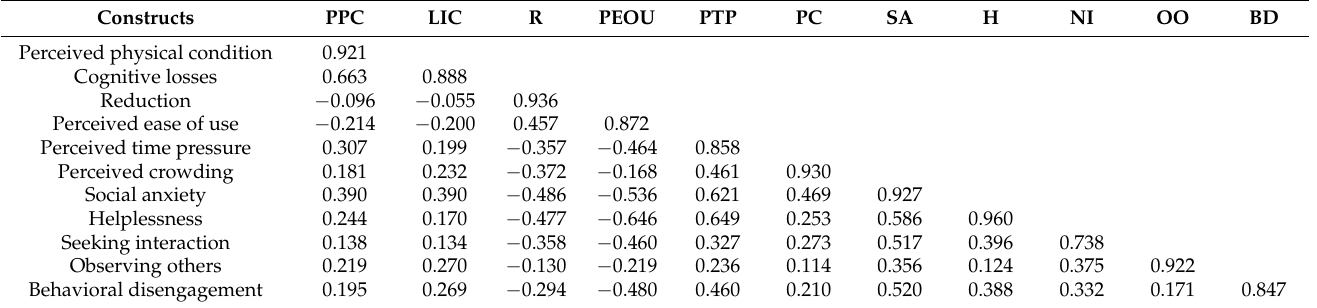
Table 3. Discriminant validity (Fornell and Larcker, 2015; [94]).